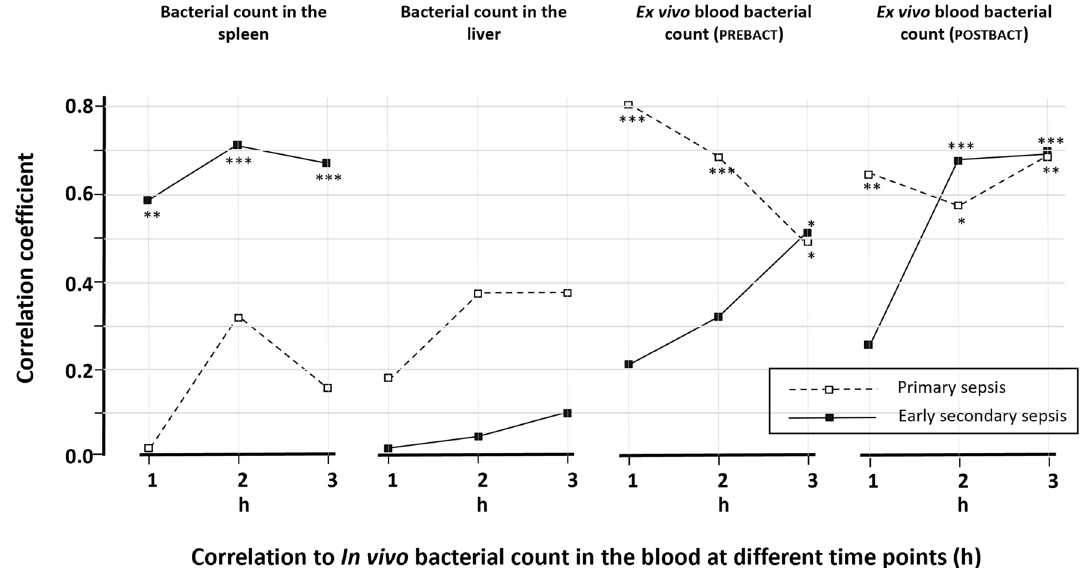
Figure 3. Spearman rank correlation analyses between in vivo bacterial count in the blood at 1–3 h and the bacterial counts in the spleen and liver, ex vivo PREBACT bactericidal clearance at 6 h in blood before the bacterial challenge and ex vivo POSTBACT bactericidal count at 3 h in blood after the bacterial challenge. The correlations between bacterial count in the blood and the two ex vivo clearances are negative but to relate to the positive values on the y-axis, these correlations are expressed as ex vivo bacterial count at the last determination after 6 and 3 h, respectively. * p < 0.05, ** p < 0.01, *** p <